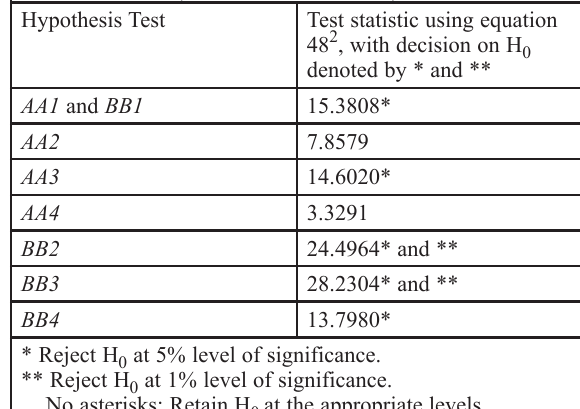
Table 2 : Test statistics for hypotheses tests on variance-cova- riance matrices for mean distance refractive state using ∑ 2 as reference value (same as Gillan 1 ), that is, tests AA1 to AA4 , as well as test statistics for hypotheses tests on variance-covari- ance matrices for mean distance refractive state using ∑ 1 as reference value, that is, tests BB1 to BB4 . Note that the tests AA1 and BB1 are identical. The value of k is 2. The respective null hypotheses (H 0 ) are that the variance-covariance matri- ces for the mean distance refractive states are equal. Critical values are  2 0.05, 6 = 12.592 and  2 0.01, 6 = 16.812 Hypothesis Test Test statistic using